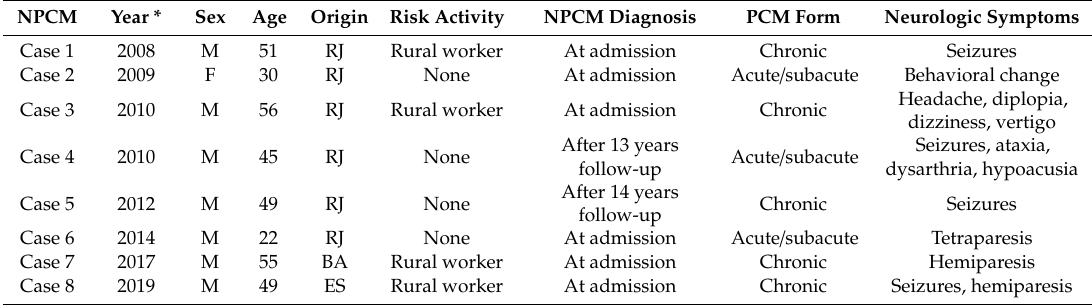
Table 1. Epidemiological and clinical features of the neuroparacoccidioidomycosis (NPCM) cases from this study.